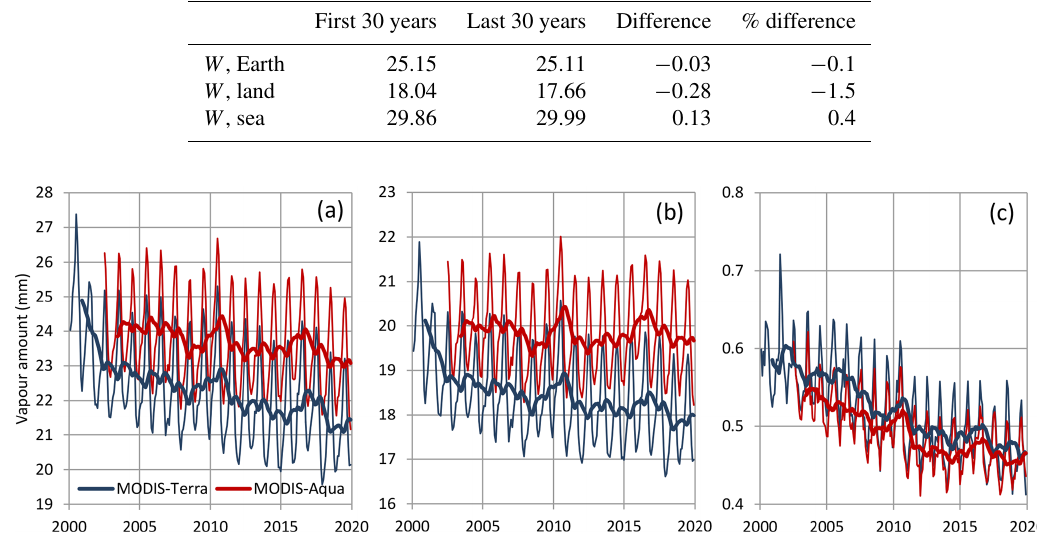
Figure 8. Variation of water vapour amount, as in Fig. 7, but only for the MODIS data set and separately for the Terra and Aqua platforms: (a) total of the vertical column, (b) from surface to 680hPa and (c) from 440 to 10hPa. Thin and thick lines of the same colour represent monthly values and running annual averages (right aligned), respectively. Sources of the data are indicated in the legend and detailed in